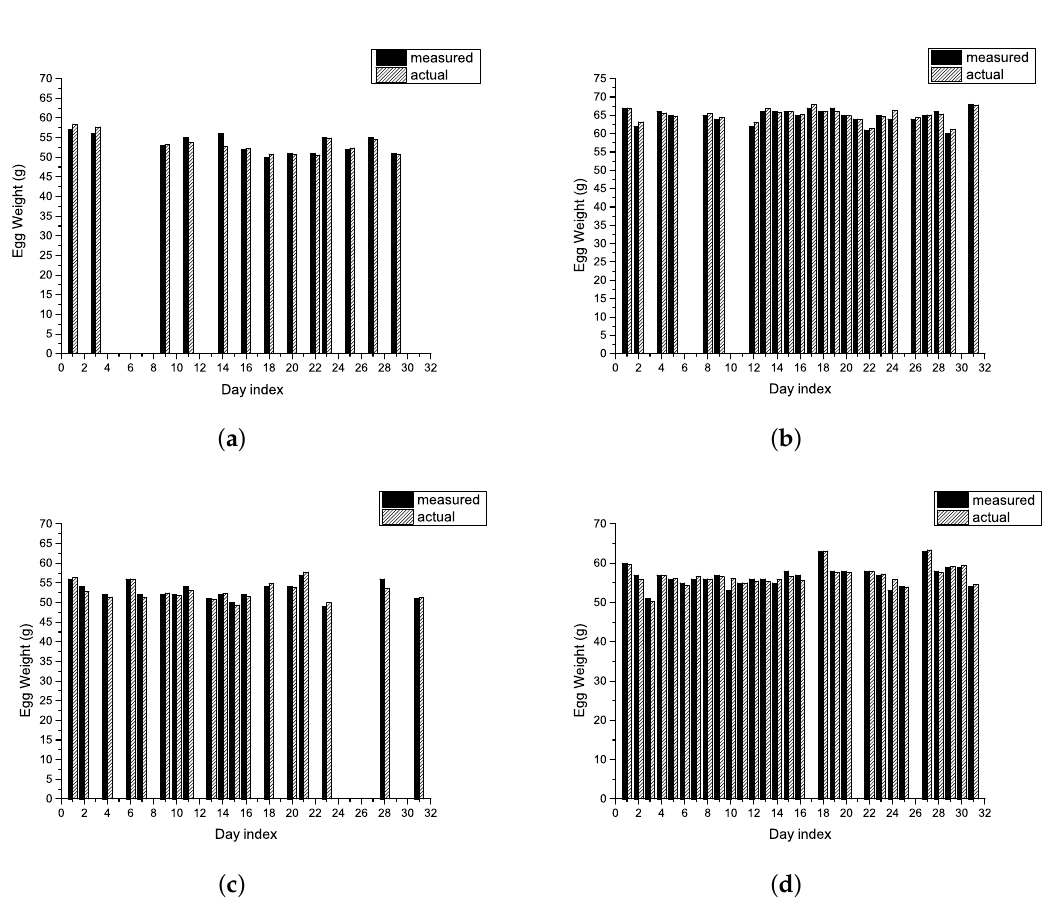
Figure 8. The daily measured vs. actual weights of eggs for the individual hens. ( a ) Hen with ID 21; ( b ) Hen with ID 22; ( c ) Hen with ID 23; ( d ) Hen with ID